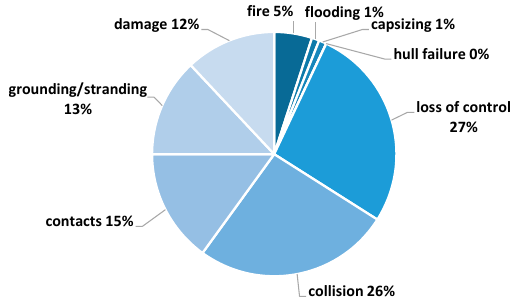
J. Mar. Sci. Eng. 2020 , 8 , x FOR PEER REVIEW Figure 6. Casualty events for ships in the period 2011–2019. Figure 6. Casualty events for ships in the period 2011–2019.